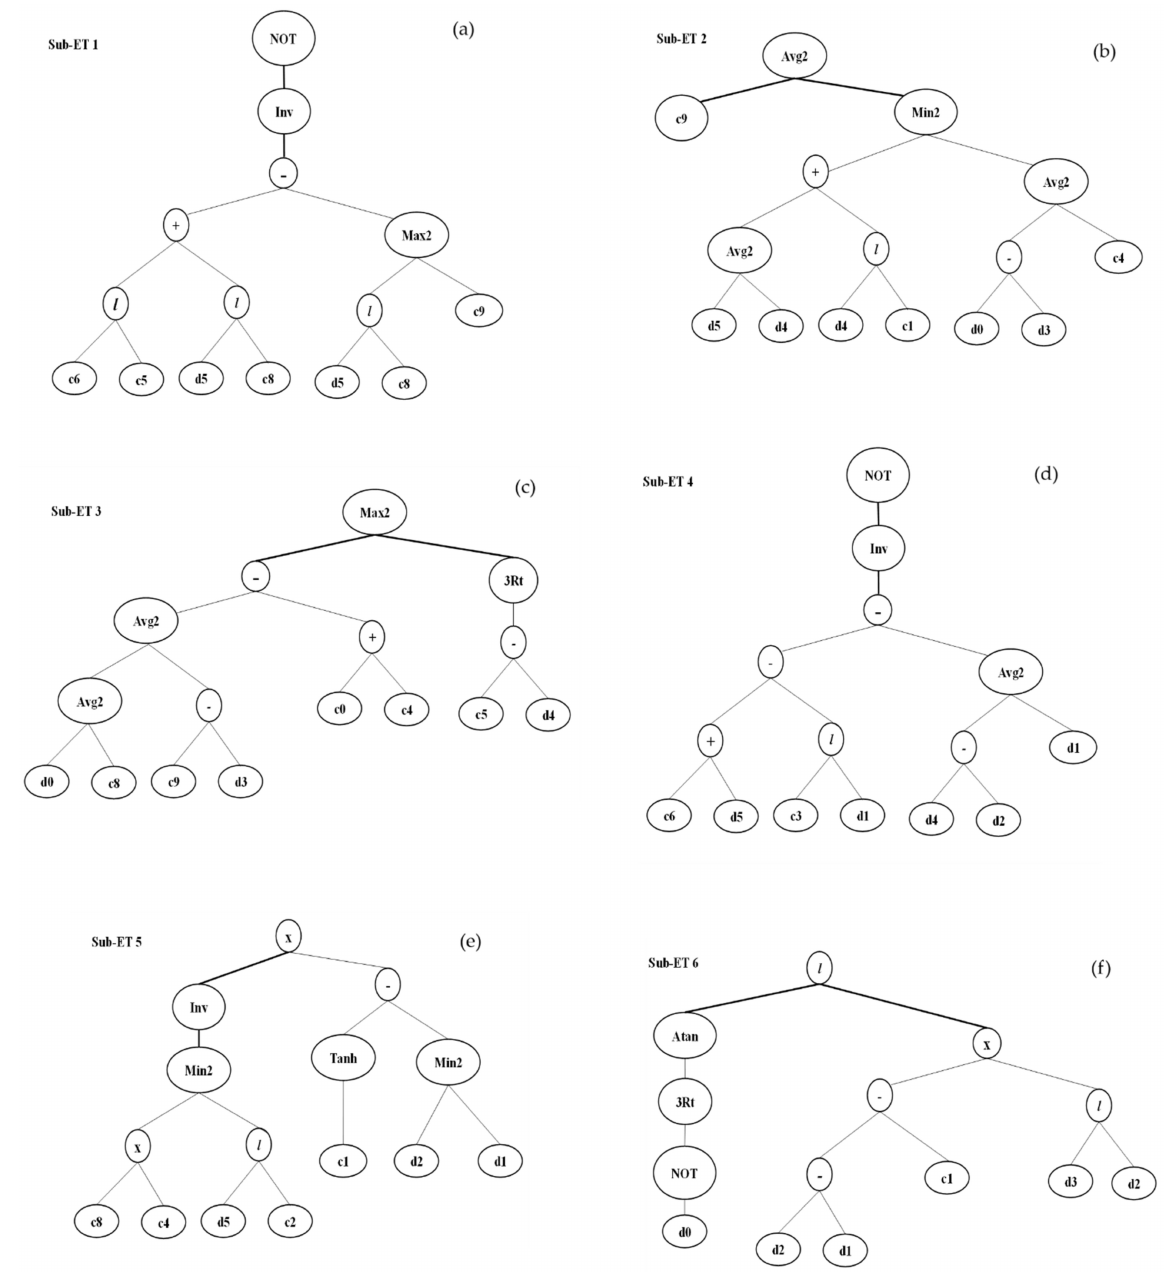
Figure 10. GEP expression tree for compressive strength ( a ) sub-ET 1; ( b ) sub-ET2; ( c ) sub-ET 3; ( d ) sub-ET4; ( e ) sub-ET5; ( f )